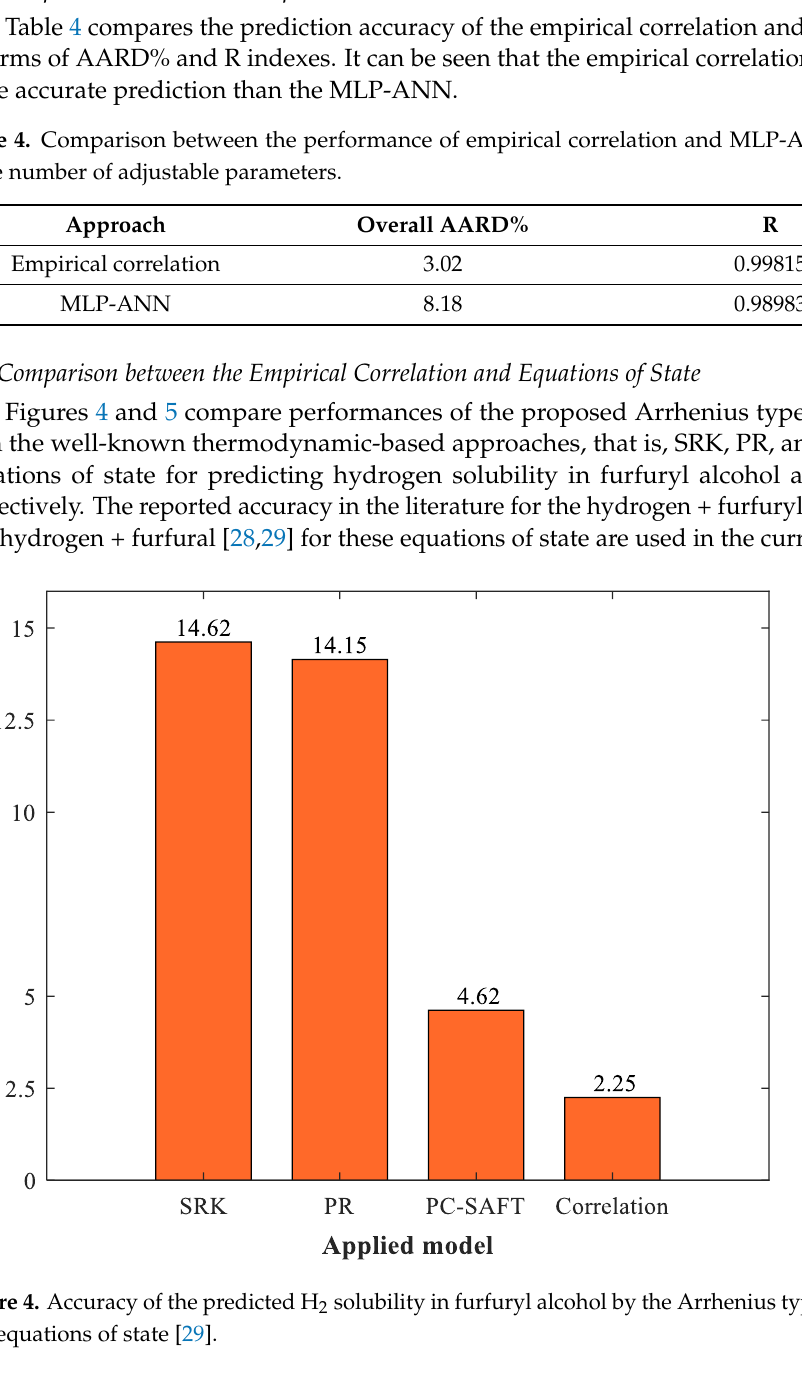
Figure 5. Accuracy of the predicted H 2 solubility in furfural by equations of state [28,29] and the Arrhenius type correlation.